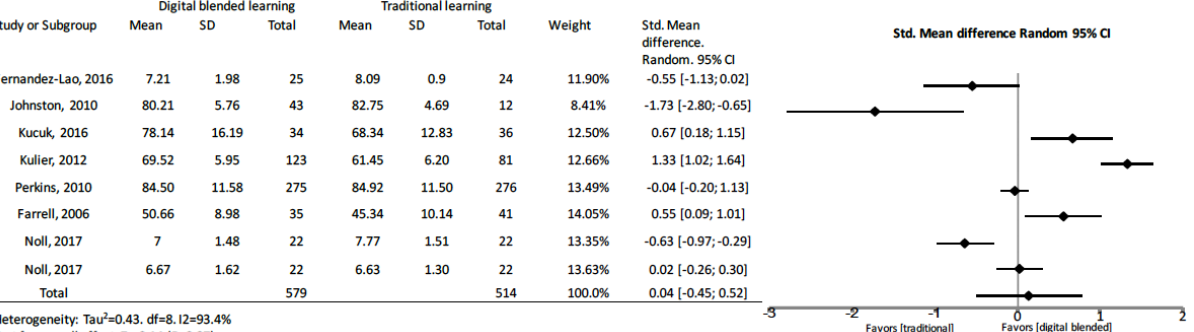
Figure 6. Forest plot of digital blended learning to traditional learning comparison for knowledge outcomes. df: degree of freedom; CI: confidence